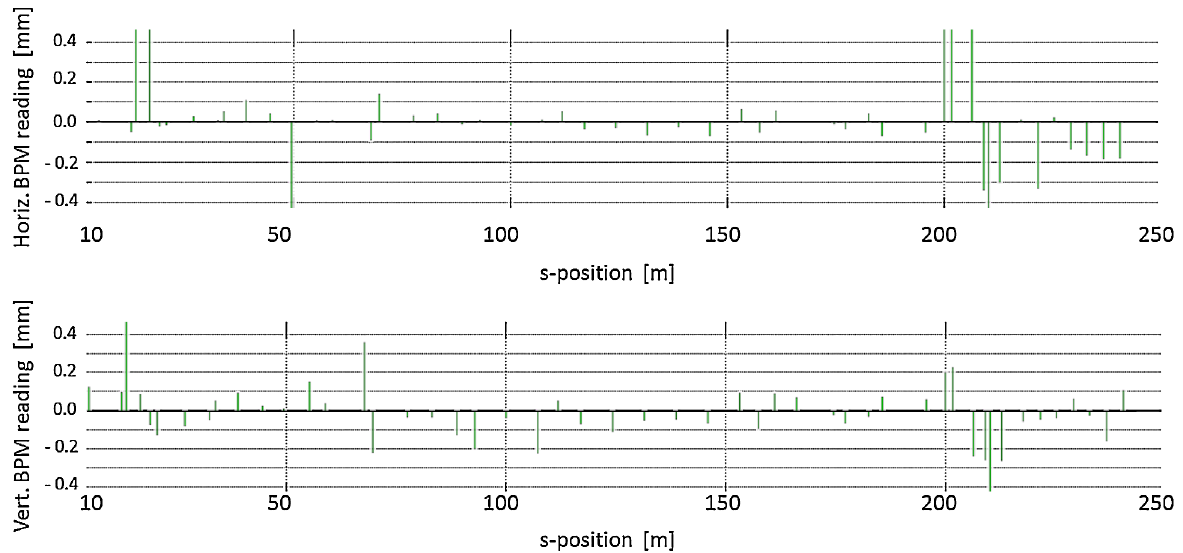
FIG. 10. Trajectory correction in the horizontal (top) and vertical plane (bottom), from the injector end to the linac end, as measured and displayed by the control system. The very large bars in the LH area ( s position (cid:3) 20 m ) and BC1 area ( s position (cid:3) 50 m ) correspond to bad BPMs reading; these are excluded from the steering algorithm. The large bars in the right side of the plot ( s position > 200 m ) are in the transfer line area that was not included in the steering algorithm at the time of this measurement. The correction has been performed with the theoretical TRM shown in Fig.